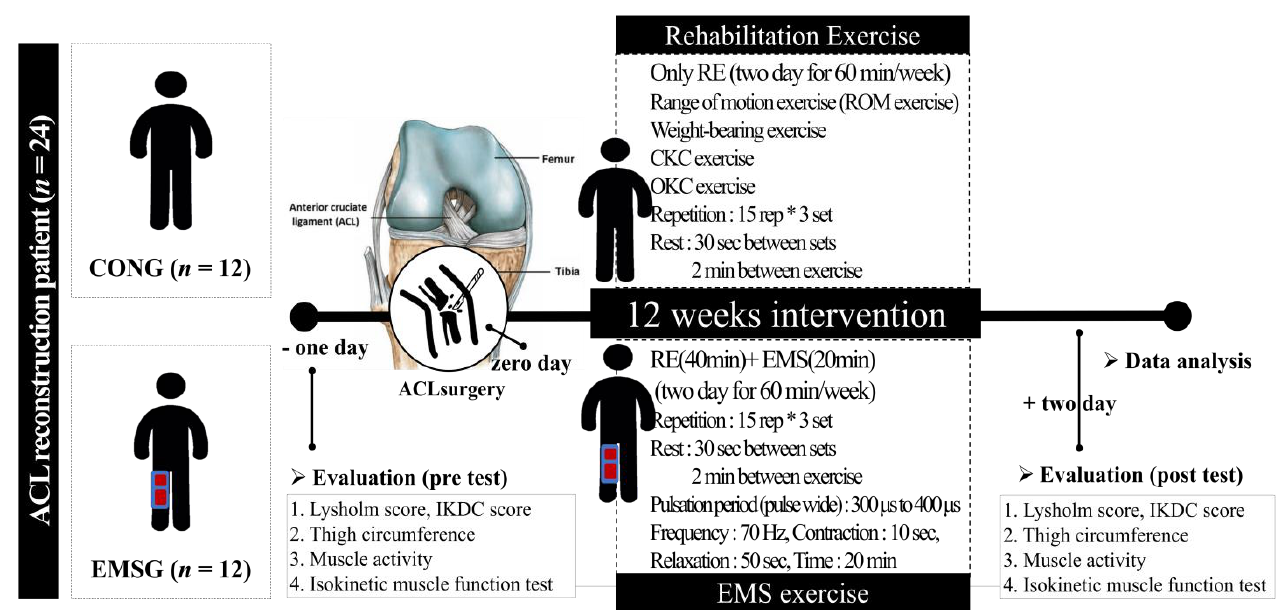
Figure 2. Experimental process. control group; CONG, electro muscle stimulation group; EMSG.